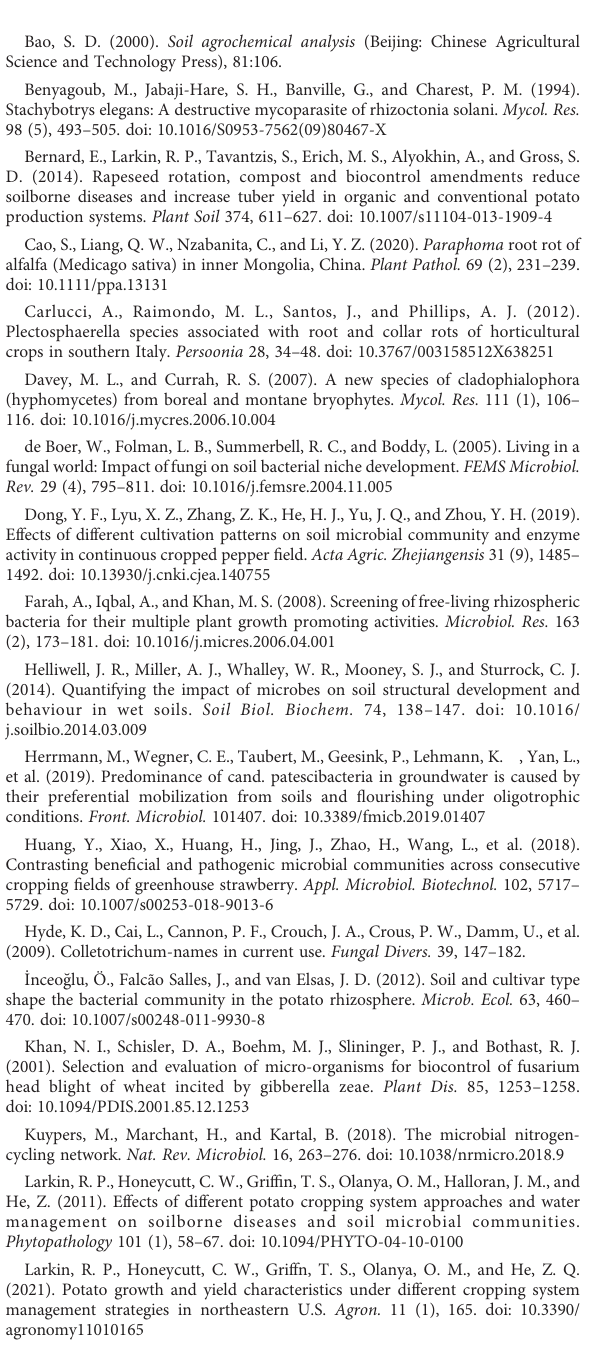
SUPPLEMENTARY FIGURE 2 Relative abundance of dominant fungal phyla (A) and genera (B) among different treatments. Lowercase letters indicate signi fi cant differences at P < 0.05 level. B_910, O_910, PC_910 and PR_910 indicate the samples from B, O, PC and PR treatments at harvest. SUPPLEMENTARY FIGURE 3